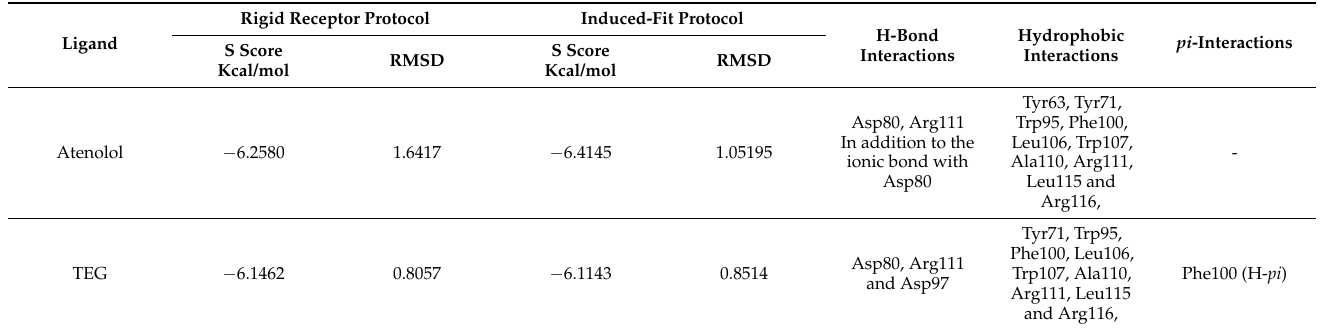
Table 2. Docking results for both TEG and atenolol with the E. coli SdiA QS receptor .